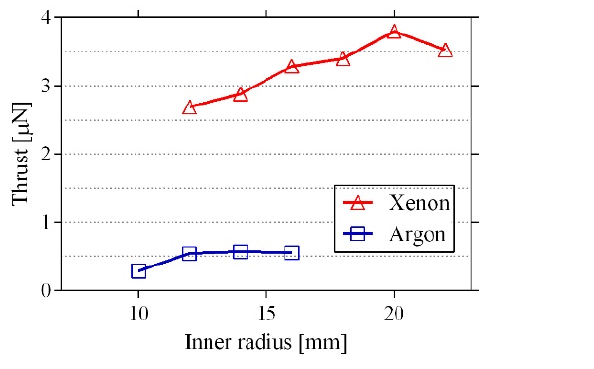
( b ) Figure 4. Influence of the cylindrical height in the thruster’s performance at 20 kV: ( a ) variation of the output thrust T in ( μ N) for several heights (mm); ( b ) variation of the thrust ‐ to ‐ power ratio T / P in (mN/kW) for several radius (mm). With argon as the propellant gas, we verified that the width was already optimized in 12 mm, as any other variation, upper or lower, would decrease the output thrust and the thruster efficiency. On the other hand, when using xenon, we concluded that the op ‐ timal hollow radius was 20 mm. With the change of the cathode’s length, we found that the xenon propellant would attain its optimal state with a length of 14.7 mm. Overall, the xenon thruster delivered an output thrust of 3.80 μ N and the thrust ‐ to ‐ power ratio of 434 mN/kW, values that when comparing with the current state ‐ of ‐ the ‐ art of the modern elec ‐ tric propulsion systems reach the same order of magnitude.